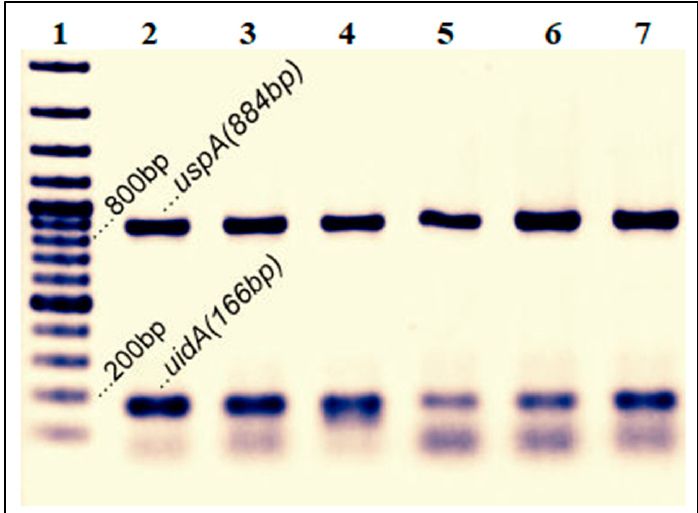
Figure 1. Presence of uidA and uspA genes in E. coli samples. Lane 1, 100 bp Ladder; Lane 2, Escherichia coli ATCC 25922 was used as a positive control; lane 3, 4, 5, 6, and 7, isolated experimental isolates. Table 2. Antibiotic resistance phenotype of E. coli isolated from different samples.